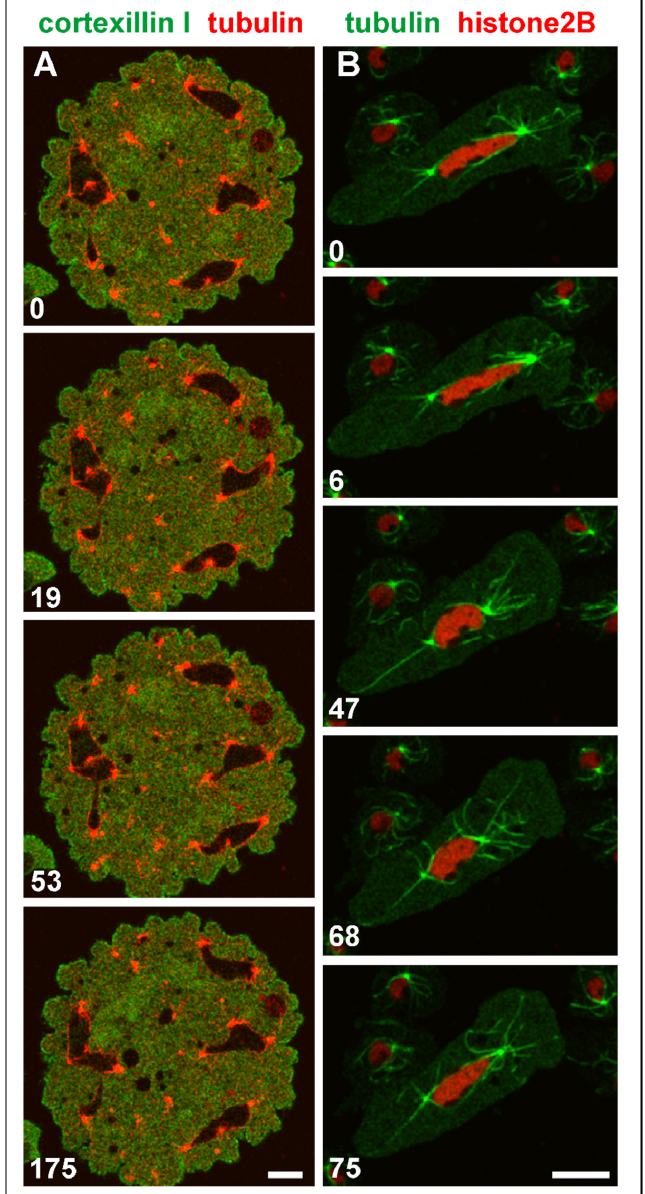
Figure 9. Shape changes of large nuclei with multiple centrosomes. ( A ), a multinucleate Septase-null cell that expressed RFP- α -tubulin to label centrosomes and microtubules (red) and GFP-Cortexillin I (green), which localizes to the cytoplasm such that the nuclei appear as black areas in this interphase cell. The cell is also shown in Video S5. ( B ), elongation of a large nucleus between two centrosomes that were anchored by microtubules to opposite positions of the cell cortex. The RacB-null cell expressed GFP- α -tubulin to label the mitotic apparatus (green), and RFP-histone2B for the nucleus (red). Long microtubules that anchor the centrosomes to the cell cortex are seen in the 47-s, 68-s, and 75-s frames. The cell is also shown in Video S6. The cells in ( A , B ) were compressed by an agar overlay. Time is indicated in seconds. Bars, 10 µm.